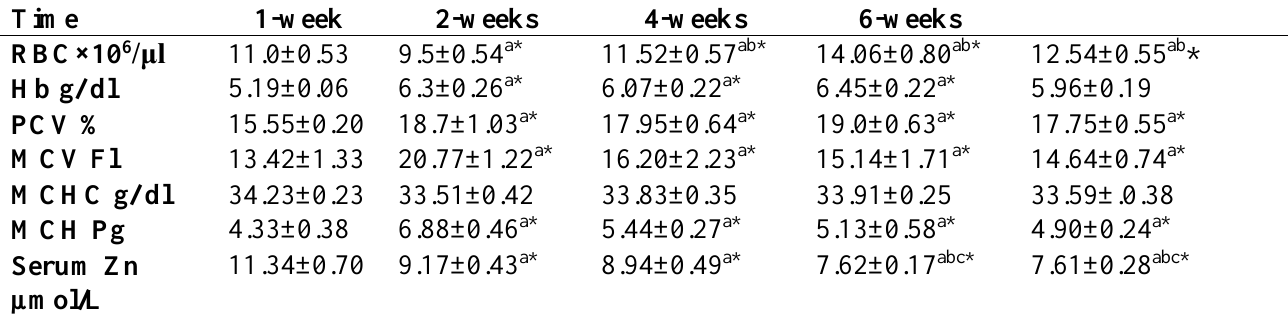
Table 3. Hematological parameters and serum Zn in experimentally induced zinc deficiency goats